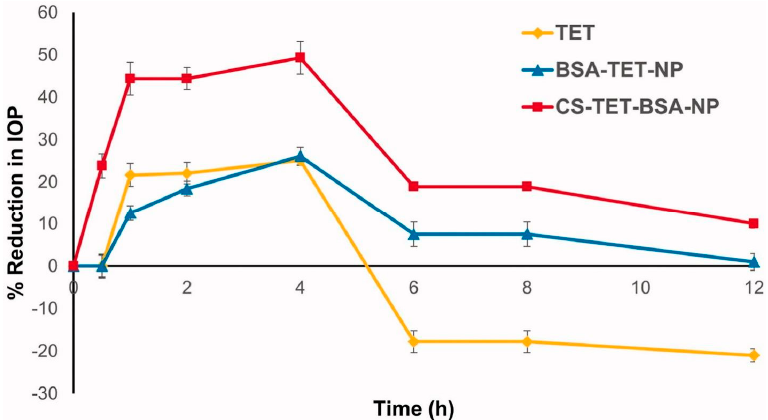
Figure 9. Illustration showed the results of antiglaucoma activity of different treatment investiga- tions (TET: Tetrandrine suspension; TET-BSA-NPs: Tetrandrine loaded bovine serum albumin na- noparticles; CS-TET-BSA-NPs: Chitosan-coated bovine serum albumin nanoparticles containing tetrandrine). It highlights that the coating of chitosan over the bovine serum albumin nanoparticles is further helpful to reduce the IOP in rabbit glaucoma model compared to bovine serum albumin nanoparticles and tetrandrine suspension. Reproduced from Radwan et al. [45], Informa UK